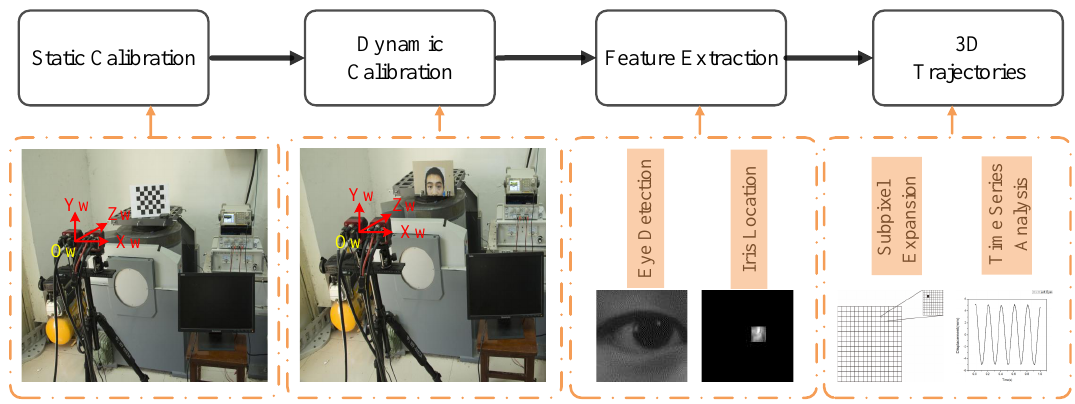
Figure 1. Procedure for reconstructing three-dimensional (3D) eye